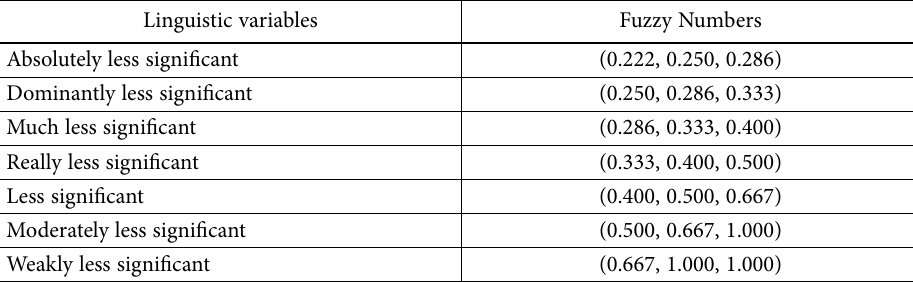
Table 2. The linguistic variables for the evaluation of the criteria (Scale 0–1) (Stević et al., 2018) Linguistic